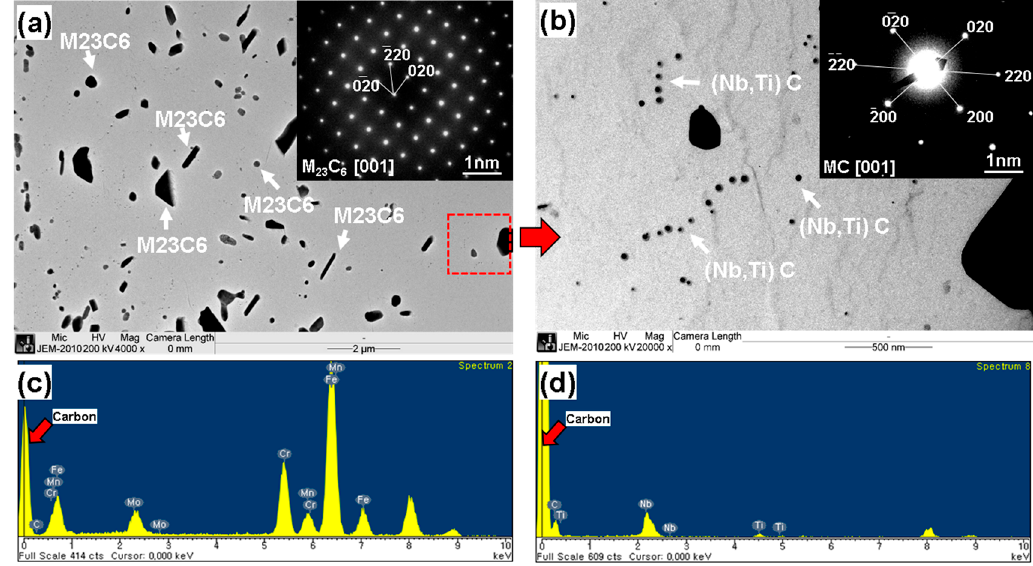
Figure 12. Transmission electron microscopy (TEM) micrographs of C-containing phases in advanced alloy. ( a ) Image of M 23 C 6 (FCC; zone axis of [001]); ( b ) image of MC (FCC; zone axis of [001]); ( c , d ) energy-dispersive X-ray (EDX) spectra from precipitates ( a , b ).